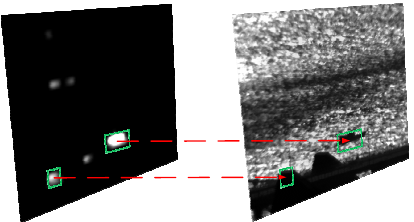
Figure 14. Determine the location of the block to be matched in the original image. Step two: calculate the highest normalized cross-correlation matching coefficient NCC between the two block images of the current frame and the former frame, as shown in Equation (6). C represents the current frame data, F represents the former frame data and C and F represent the average value of the corresponding data. The best matching position is the pixel position of the maximum NCC calculated from the whole image. The difference between the best matching position and the position of the block images of the current frame is inter frameshift at this time. If the inter frameshift of the two blocks to be matched is highly similar, it is regarded as valid data, and the shift is recorded as , respectively. Once the similarity is not high, the inter-frame jitter shift generated by the blocks with a lower similarity is discarded.